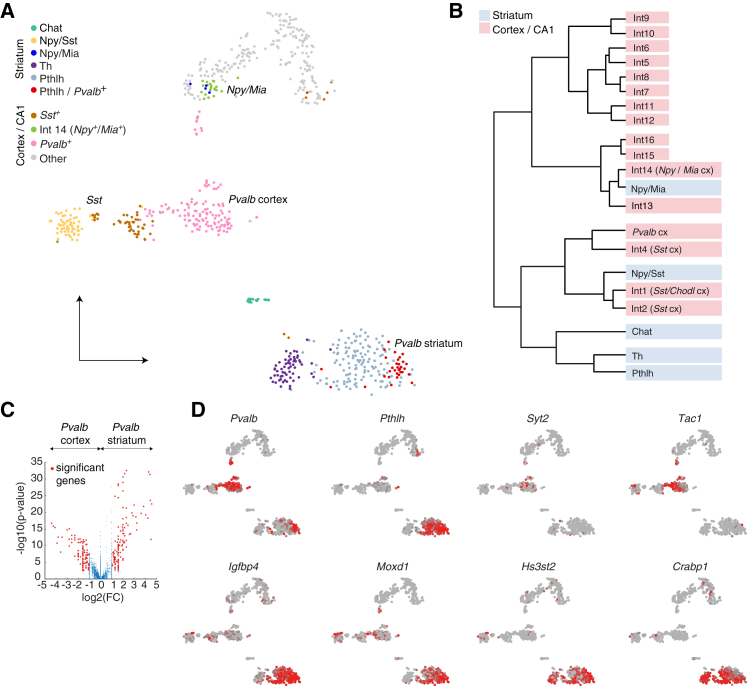
Comparing Single-Cell Transcriptomes of Interneurons from the Striatum and Cortex and Hippocampus(A) tSNE visualizations of the individual transcriptome of striatal (dataset A) and cortical-hippocampal interneurons.(B) Hierarchical clustering of the same cell populations shown in (A).(C) Differential gene expression analysis of striatal Pvalb-positive cells and their cortical counterparts. The y axis represents the log10 (p value) acquired using Wilcoxon rank-sum test, and the x axis shows the log2 (fold change). Significantly differentially expressed genes are marked in red.(D) tSNE plots showing examples of differentially expressed genes in Pvalb+ cells in striatum and cortex and hippocampus.See also Table S4.